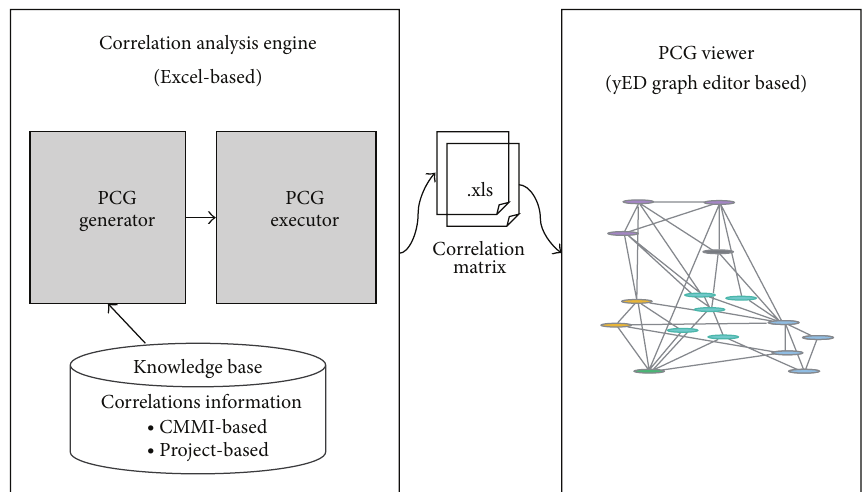
Figure 10: Prototype tool components.